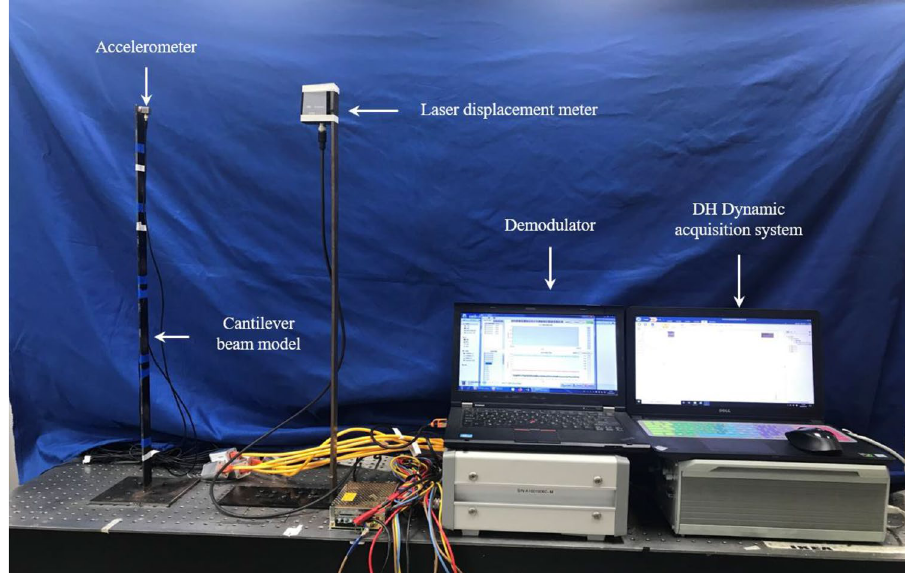
Figure 12. Vibration experiment system.